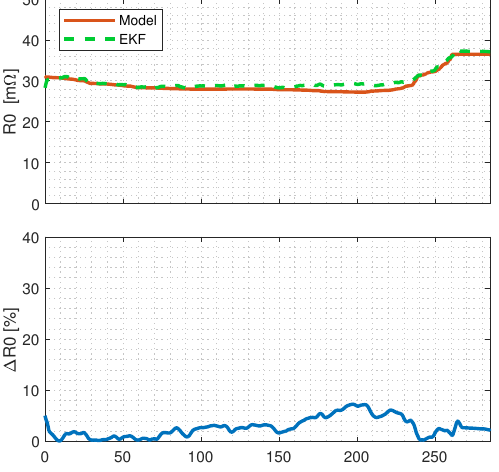
Figure 11. Samsung 500 cycle, type “C”. Comparison between the internal resistance R 0 estimated by the GO-EKF and the resistance used in the reference